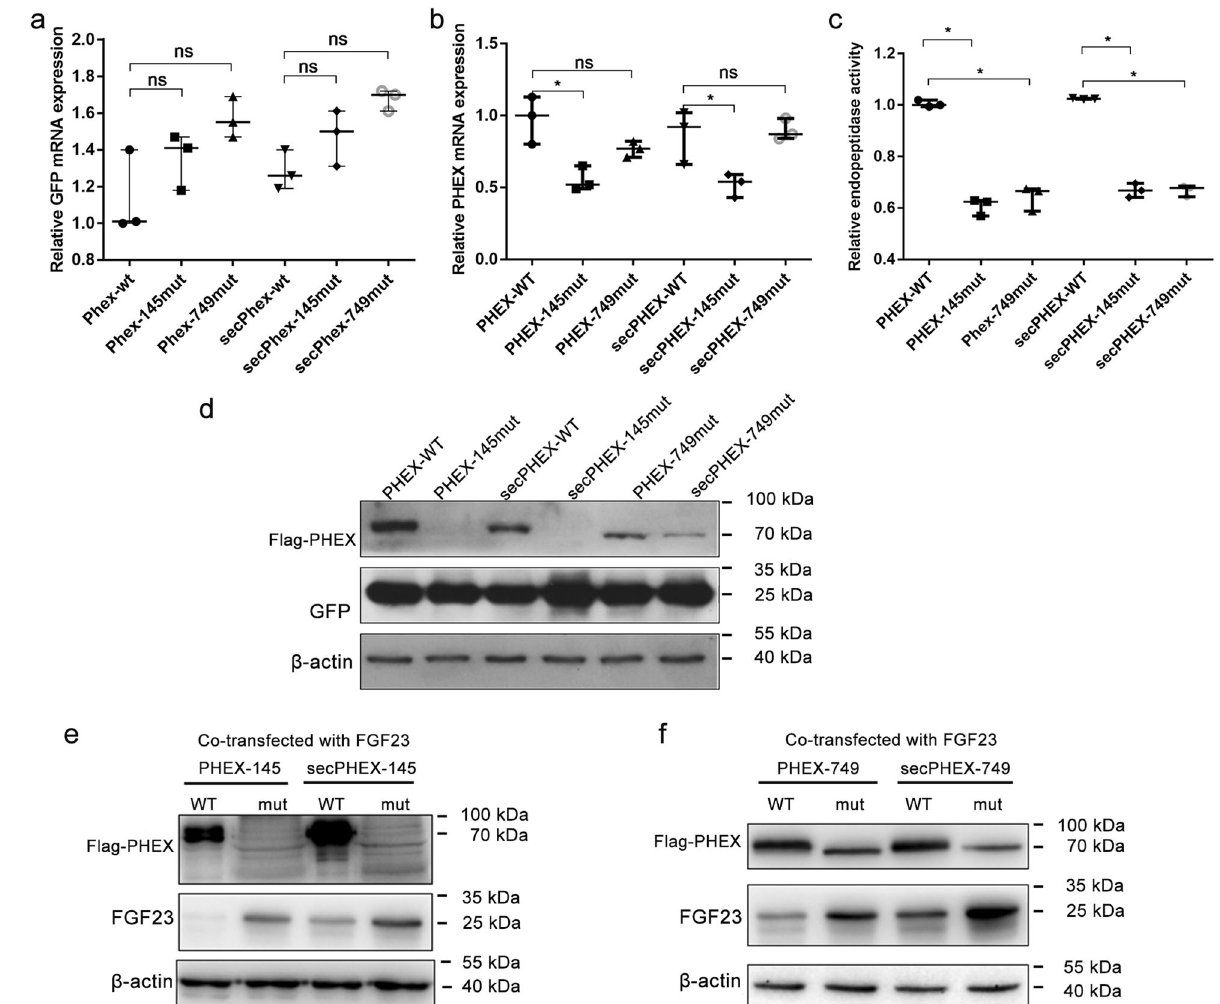
Fig. 4 Functional identi fi cation of PHEX p.Glu 145* and p.Trp749Arg. a , b The expression of PHEX , sec PHEX and green fl uorescence protein ( GFP ) in transfected HEK293T cells, as detected by quantitative polymerase chain reaction (qPCR). Under the condition that the internal reference glyceraldehyde 3-phosphate dehydrogenase ( GAPDH ) is relatively consistent among each group, the expression concentration of GFP in the external reference are the same. The expression of mRNA in cells decreases by PHEX and sec PHEX p.Glu145* nonsense mutations (median ± range, n = 3, nonparametric tests, * p < 0.05); there is no difference in the expression of mRNA in p.Trp749Arg. c p.Glu145* and p. Trp749Arg mutants all lead to the decrease in intracellular PHEX endopeptidase activity (median ± range, n = 3, nonparametric tests, * p